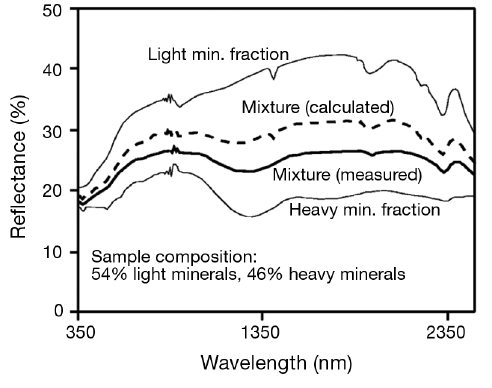
Fig. 5. Measured spectrum of a sand sample from the area of fig. 1a (bold line), relative light and heavy mineral fractions (thin lines), and calculated spec- trum (dashed line) with weighted light and heavy fractions corresponding to the original sample com- position. The measured sample overestimates the heavy mineral